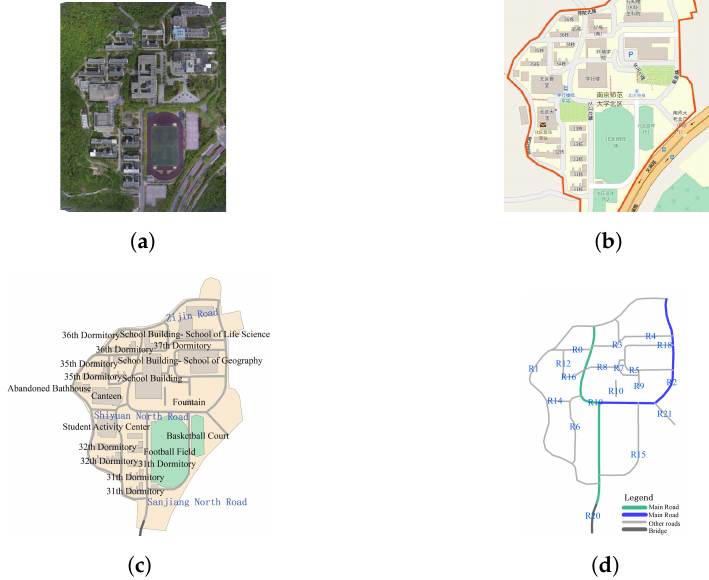
Figure 16. Experiment area and the roads in the experiment area. ( a ) Northern campus of Xianlin University District of Nanjing Normal University (taken by Da-Jiang unmanned aerial vehicle Phantom 4). ( b ) Metric map of the experiment area in Chinese (from OSM c (cid:13) OpenStreetMap) contributors. ( c ) Metric map of the experiment area in English (from OSM c (cid:13) OpenStreetMap contributors). The annotations in ( c ) are the English explanations of corresponding objects’ annotations in ( b ). ( d ) Roads from OSM. The numbers represent the road IDs. The green and blue roads are two main roads.